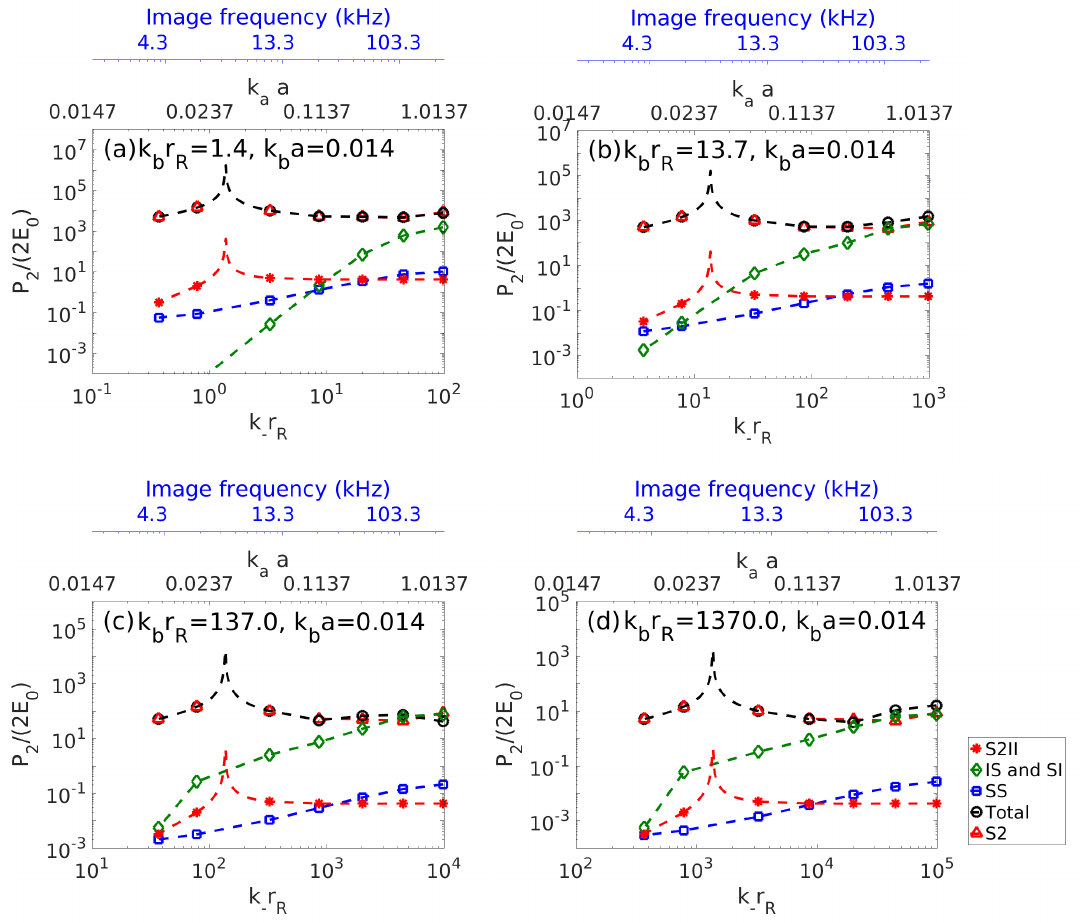
Figure 10. An acoustically compact near surface air bubble in water will resonate at roughly k b a = 0.014 (Equation (B19)). Primary pump wave frequency is then set to roughly the bubble resonance frequency which is determined by k b a = 0.014. For collinear incident waves propagating at ˆ i z , the difference frequency component of p 2 is calculated in backscatter at r R = − r R of difference frequency through k − r R . This nondimensional example may be interpreted for a 1 mm radius underwater bubble with 3.34 kHz primary pump wave frequency and image wave frequency varying through k a a = k b a + k − r R ( k b a ) / ( k b r R ) from the vicinity of 0.0167 to 1.0137 for receiver ranges ( a ) r R = 0.1 m, ( b ) r R = 1.0 m, ( c ) r R = 10 m, and ( d ) r R = 100 m as in the upper black abscissas. The upper blue abscissas are for the corresponding primary image wave frequency for this example calculated by f a = ( c /2 π a ) ( k b a + ( k − rR )( a / r R )) with sound speed c = 1500 m/s. For image wave k a a well below unity, S2 dominates and a localized peak is seen at difference frequency resonance. For image wave k a a > 1, wave-wave effects dominate at shorter receiver ranges as k a a